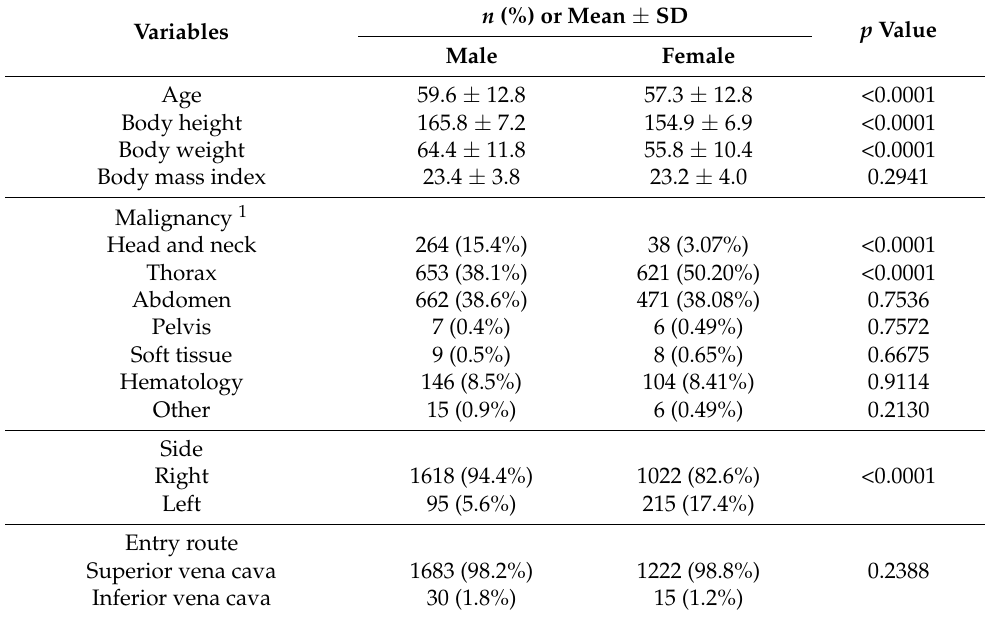
Table 1. Patient characteristics (male versus